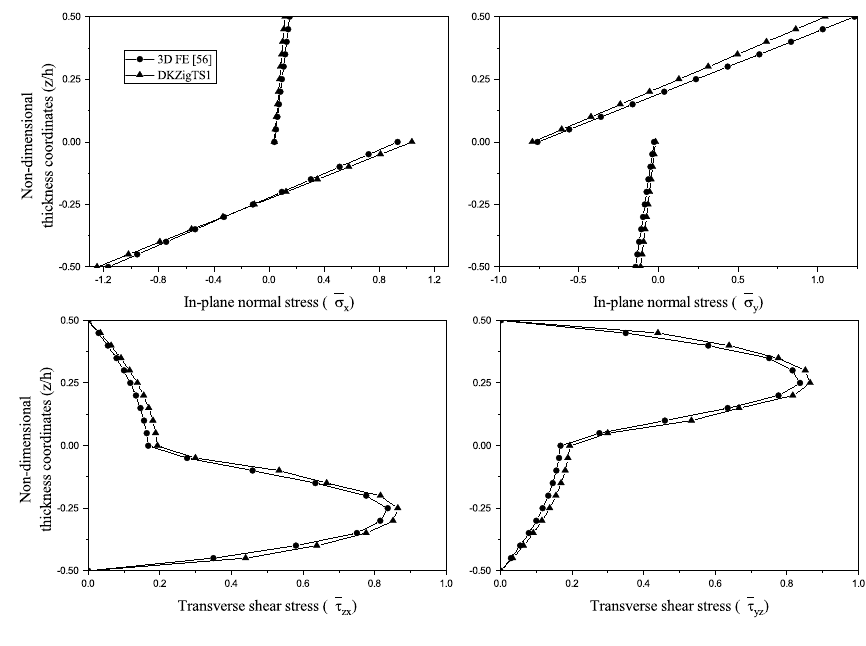
Figure 12: Through the thickness variation of in-plane normal and transverse shear stress for panel